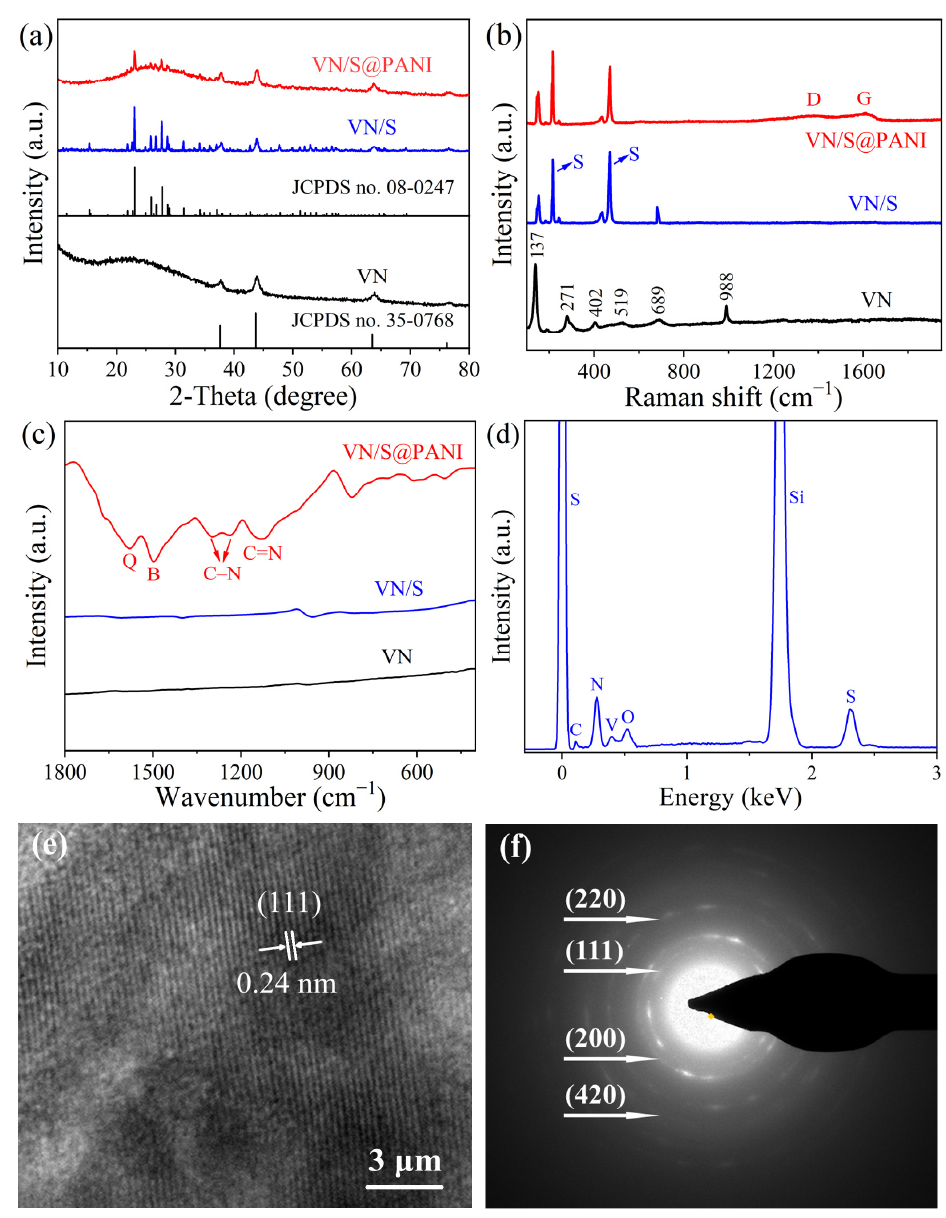
Figure 3. ( a ) XRD patterns, ( b ) Raman spectra and ( c ) FTIR spectra of VN microrods, VN/S microrods and VN/S@PANI microrods. ( d ) EDS analysis of VN/S@PANI microrods. ( e ) HRTEM image and ( f ) SAED pattern of VN microrods.